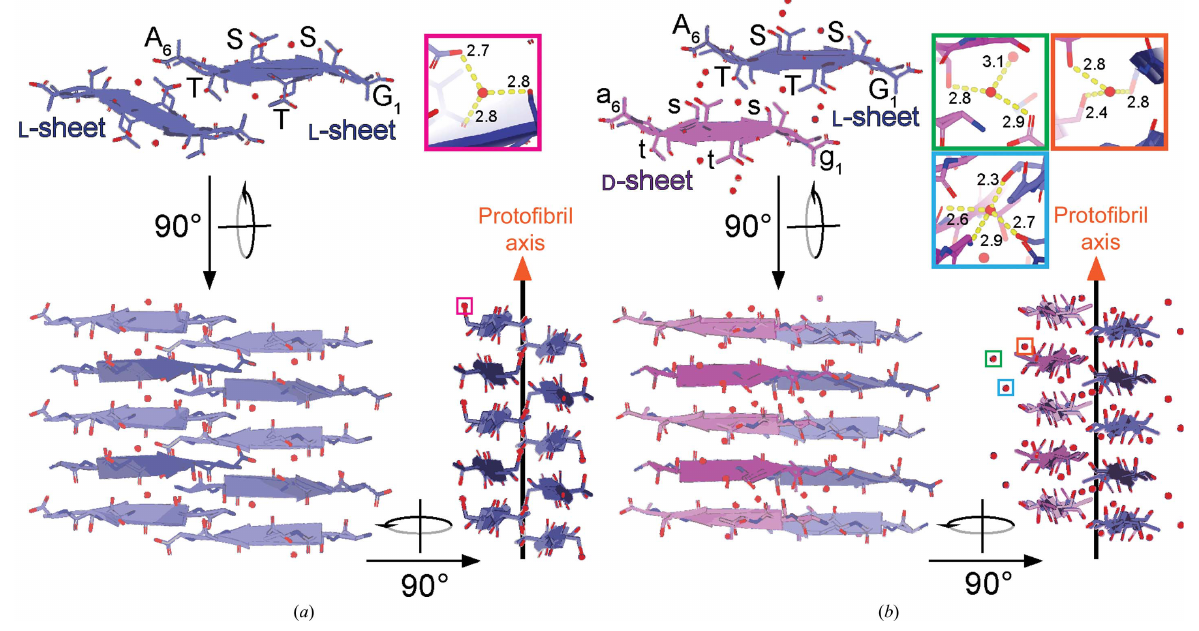
Figure 4 Views of protofibrils of l -GSTSTA ( a ) and racemic GSTSTA ( b ) represented by a pair of sheets with a view down the protofibril axis; both structures were derived by MicroED. A 90 (cid:4) rotation shows a side view of the protofibril with strands stacked along each sheet in an antiparallel fashion. Another 90 (cid:4) rotation shows a side view of the protofibril along the strand axis, showing a buckling of each sheet owing to the tilting of strands away from or towards the protofibril axis. Chains are colored such that blue represents l -peptides while magenta represents d -peptides. Lighter and darker shades of each color differentiate the orientations of strands within a sheet. Ordered waters found in each asymmetric unit are indicated by colored squares that correspond to the insets of matching colors. The insets show magnified views of each water molecule, with hydrogen bonds represented by yellow dashed lines and labeled with their corresponding distances in A˚